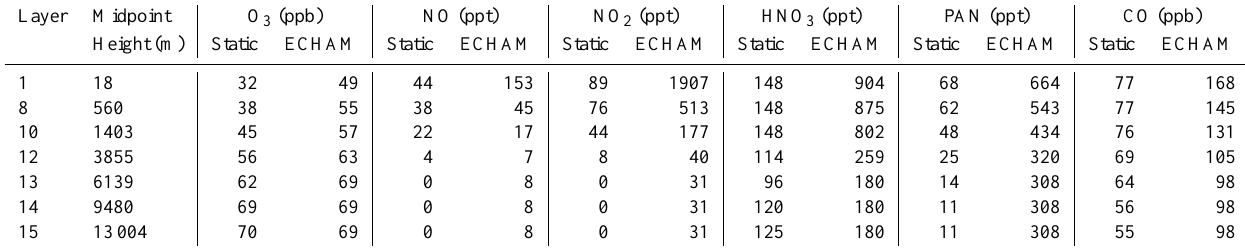
Table 2. Boundary conditions used for the CMAQ/STATIC and CMAQ/ECHAM5-MOZART simulations. The concentrations for se- lected species are shown for several vertical levels and were averaged over all sides of the modeling domain. The numbers shown for the CMAQ/ECHAM5-MOZART simulation were temporally averaged over the entire simulation length for display in this